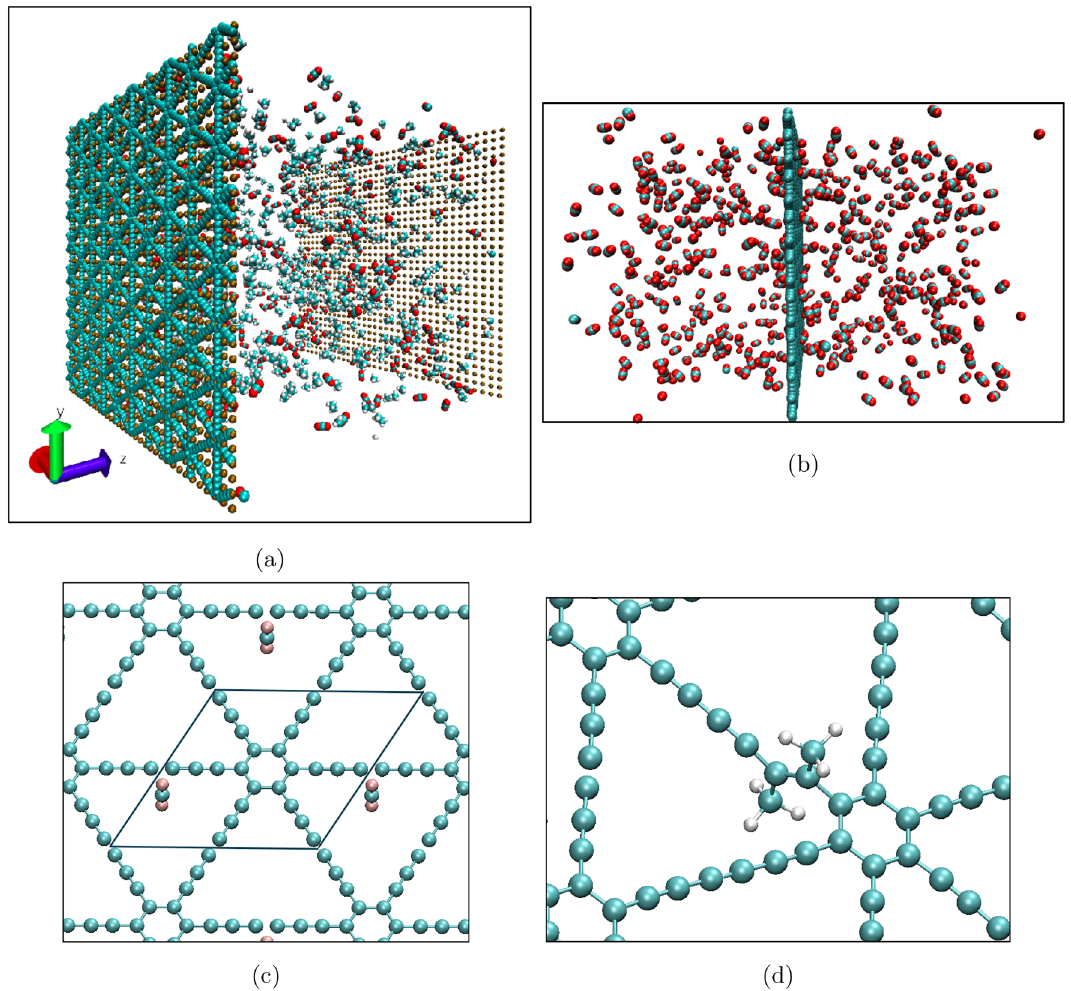
Figure 2. Simulations setup, with ( a ) and ( b ) being for MD simulations. ( a ) Series one and two, studying the separation of different mixtures at constant pressure (series 1), and the effect of pressure, mixture concentration, and system size in CH 4 /CO 2 separation (series 2). ( b ) The setup for the third series of MD simulation to determine the density profile and residence time of each molecule type. ( c ) Unit cell (black box) used in the periodic DFT calculations for determining the interaction energy between the molecule CO 2 in z -direction, and the graphyne-3 sheet. ( d ) Chemical adsorption location determined by DFT calculations where C 2 H 6 needs to be dissociated into two parts before developing chemical bonds with the sheet.